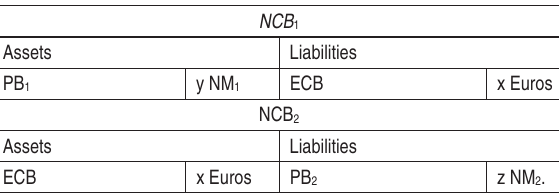
Table 4. The first phase of a cross-border payment as seen from the NCBs’